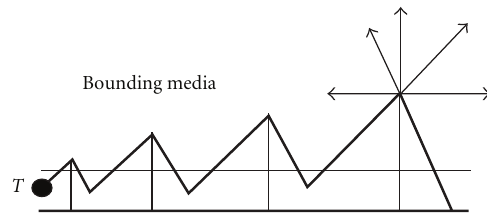
Figure 10: The figure shows a sketch of asymmetric interface for- mation on a weakly wettable surface or rod. A net potential gradient can provide a driving force. Such microstructures or nanostructures can also lead to the self di ff usion of biological molecules, liquid crystals, and so forth in various ambient